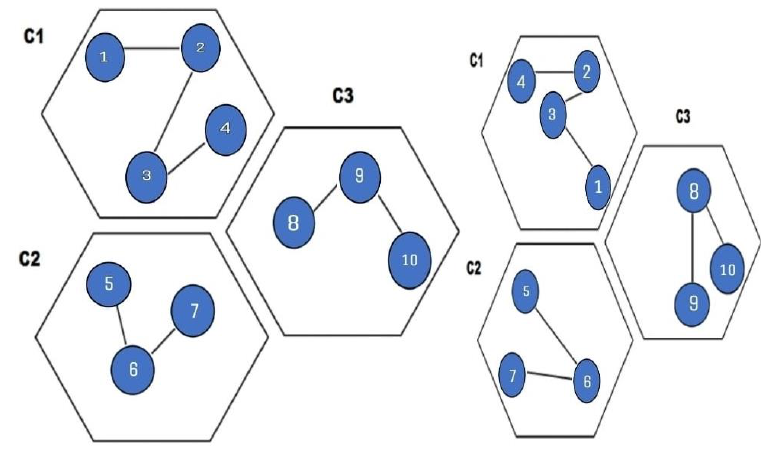
Figure 3. Intra-Cluster Connection Among Nodes.